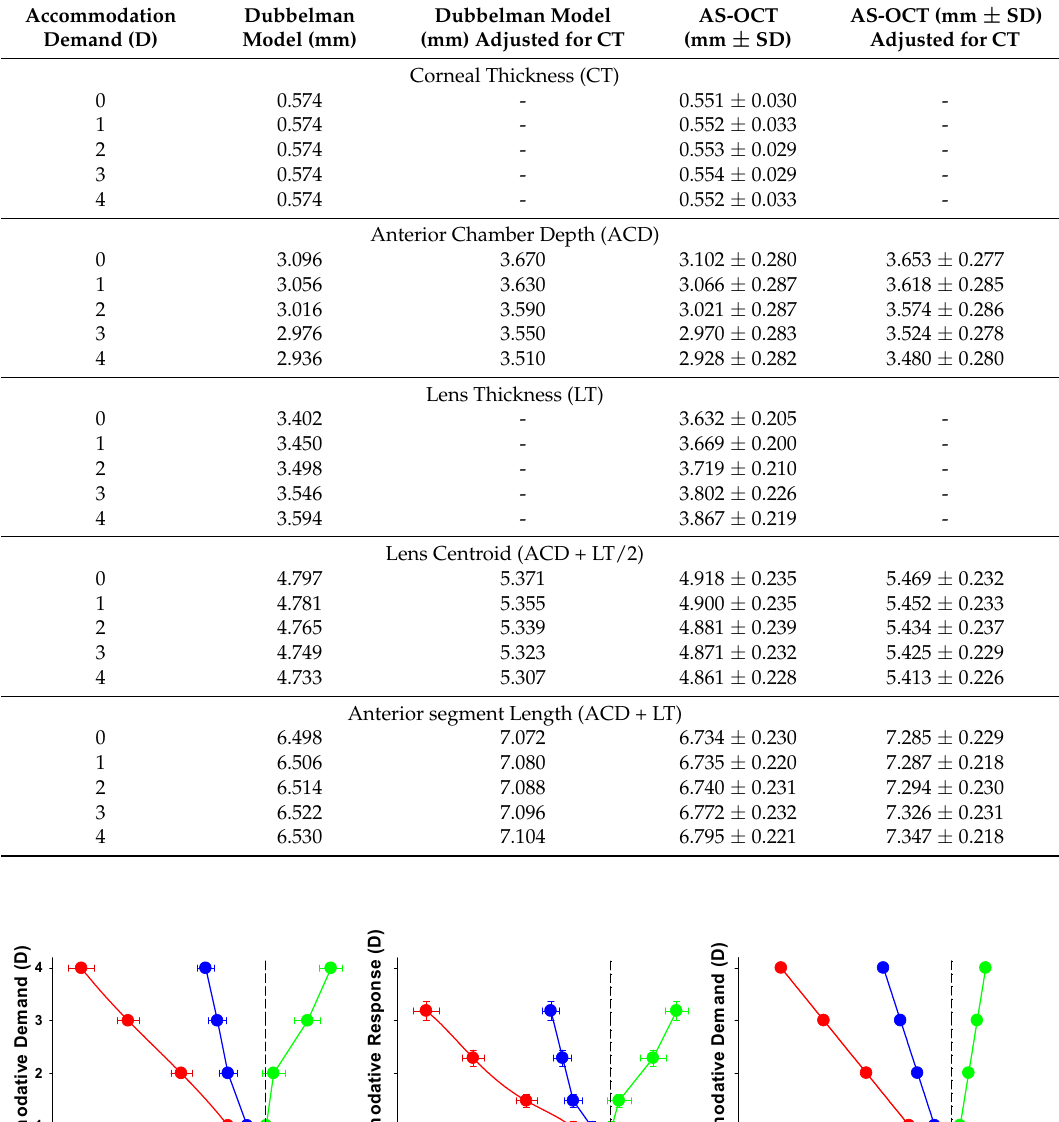
Table 2. Anterior eye axial distances and their variation with accommodation demand measured with the AS ‐ OCT, compared to the Dubbelman model eye data [65]. The average age of the cohort has been matched to that of the model (19.4 years old; n = 30). The ACD and subsequent measures have been altered to include the corneal thickness where required. To note, correction for CT is not required for measures of LT alone.